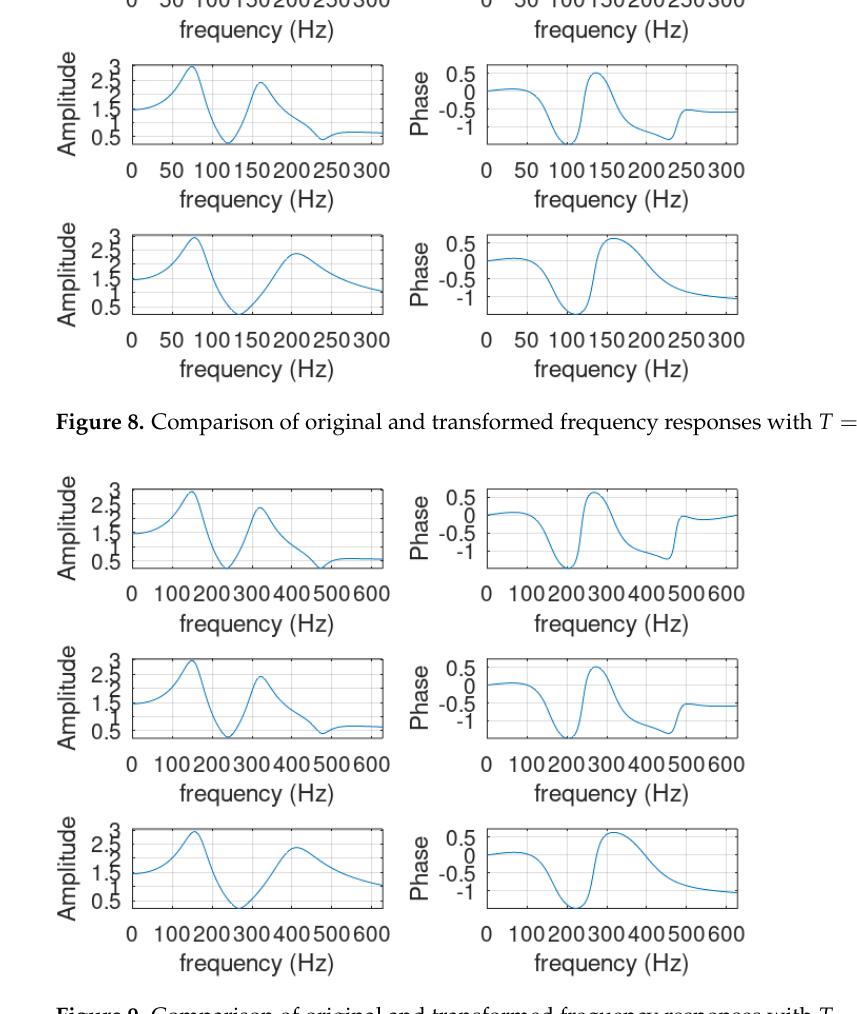
Figure 9. Comparison of original and transformed frequency responses with T =